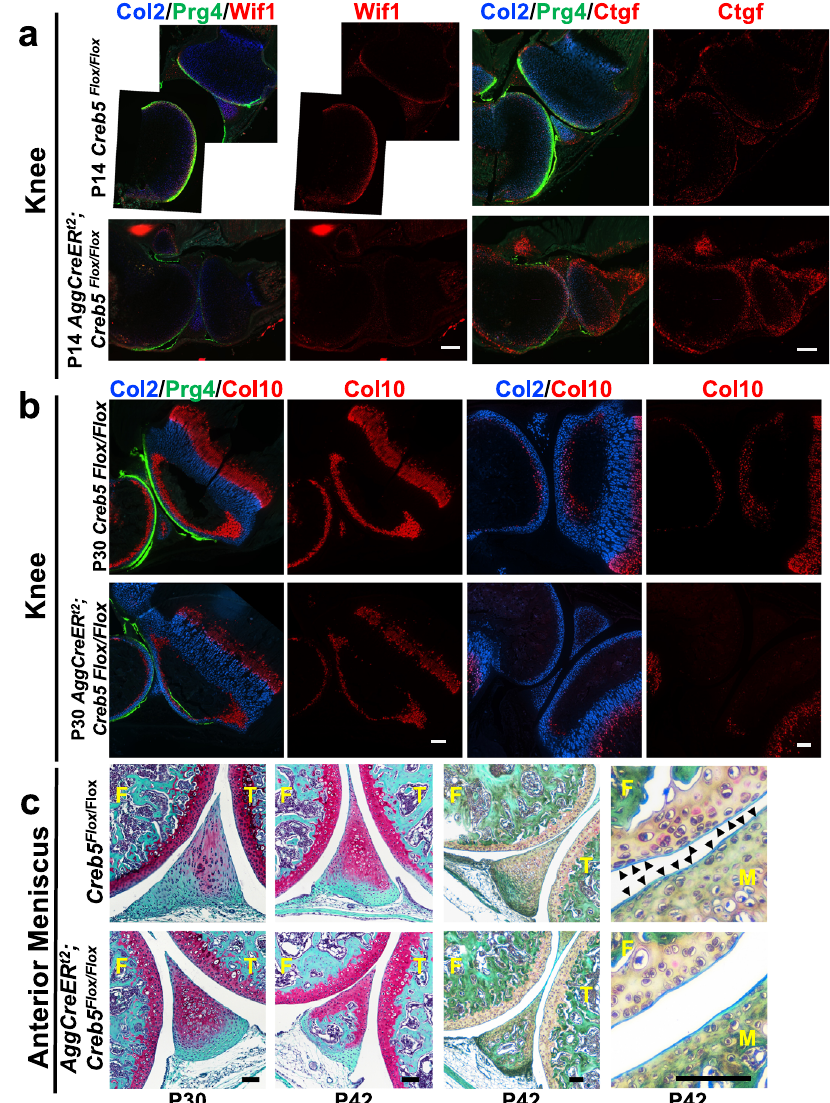
Fig.9|Creb5isnecessarytomaintainappropriatezonalgeneexpressioninthe articularcartilageandblocksprematureendochondralossi fi cationofadjacent tissues in postnatal mice. Gene expression assayed by RNAscope FISH in the hindlimbs of either P14 ( a ) or P30 ( b ) Aggrecan1 tm(IRES-CreERT2) ; Creb5 fl ox9/ fl ox9 mice or Creb5 fl ox9/ fl ox9 littermates, that had been administered tamoxifen from postnatal days 1 – 11.In each row ofimages, the left two imagesdepictthe same section; and the right two images depict the same section. Scale bar equals 200 microns in a and b . c Safranin O/Fast Green staining of the anterior meniscus (and